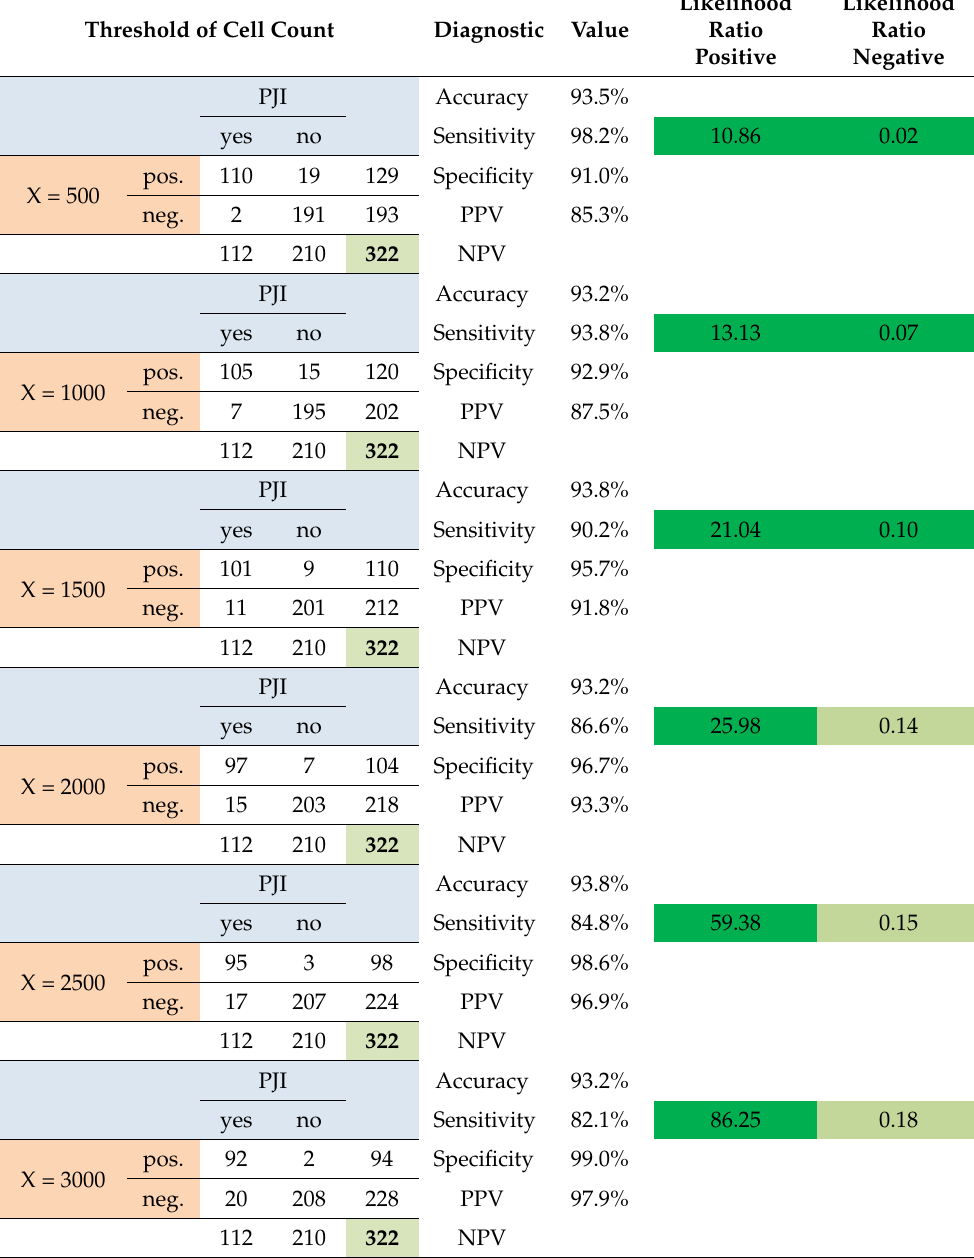
Table 3. Diagnostic value of the cell count at different thresholds (X) combined with the LMNE Type 2 or 3 (PJI); PPV = Positive Predictive Value, NPV = Negative Predictive Value., likelihood ratio green dark = superior diagnostic evidence, light green = high diagnostic